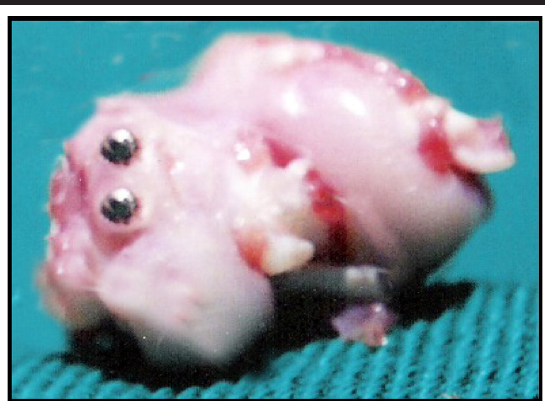
FIGURE 1 - I Fragment osteochondral put back at her bed with the 2 pins transfixed crossing the cortical lateral of the lateral femoral côndylus.